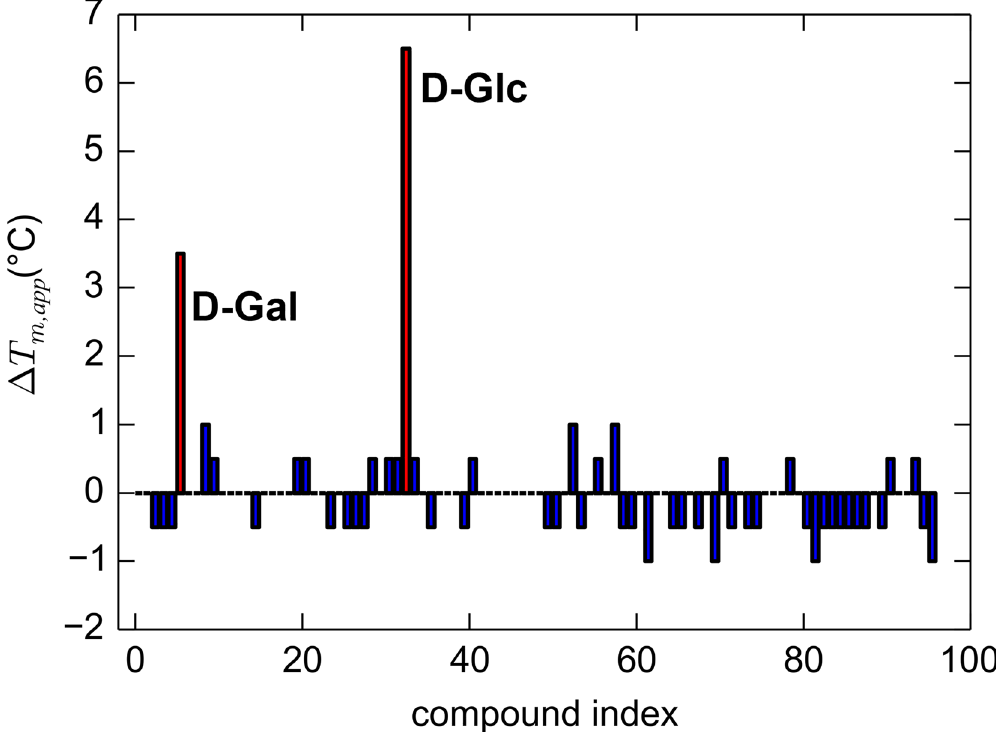
Fig 5. DSF data for a panel of carbon sources in the presence of TpMglB-2. The change in the apparent melting temperature is plotted vs. compound index (ranging from 1 to 96; only results from BIOLOG plate PM1 are shown here). Bars for compounds that caused T m , app shifts of more than 1.5° C from that observed in the presence of the negative control (water, no compound) are colored red and labeled with the compound ’ s identity.